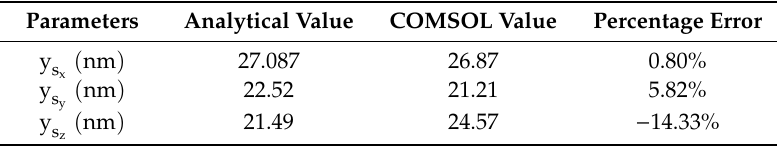
Table 5. Analytical and FEA simulated sense-displacements comparison.